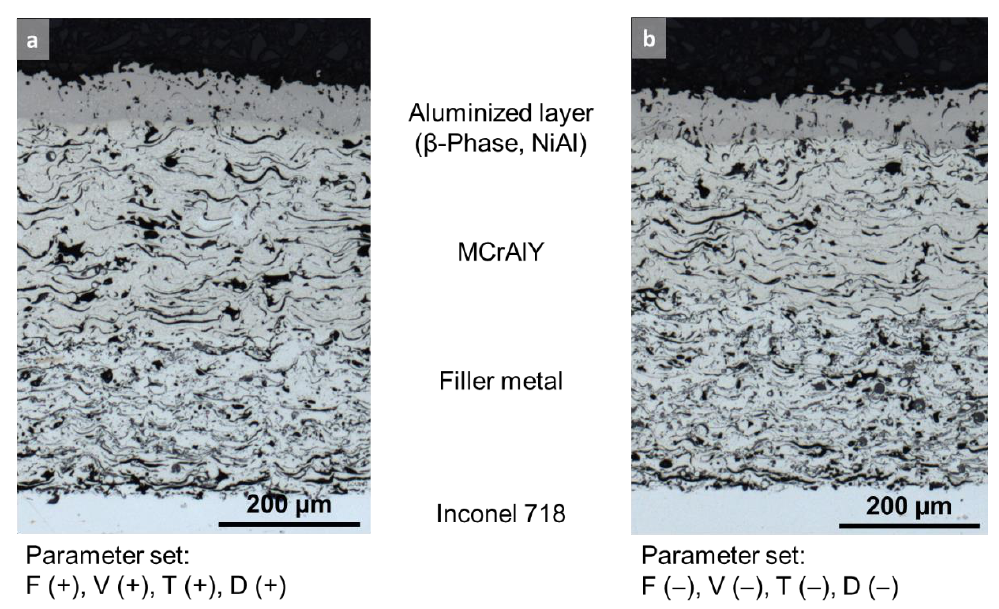
Figure 6. Optical micrographs from cross sections of brazed/aluminized samples (fine powder): ( a ) parameter set 1, ( b ) parameter set 2